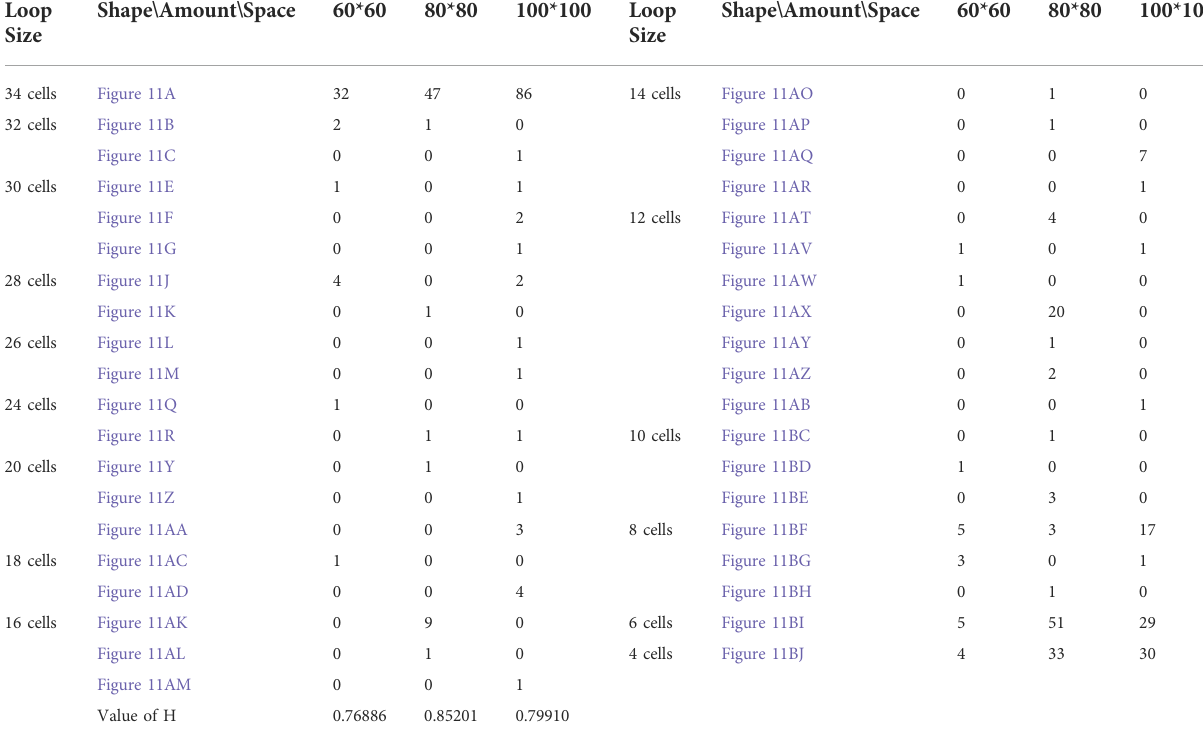
TABLE 12 Statistical numbers of the loops with various structures for the adding mechanism on different cellular spaces starting from the initial con fi guration in Figure 7D. Loop Shape ∖ Amount ∖ Size